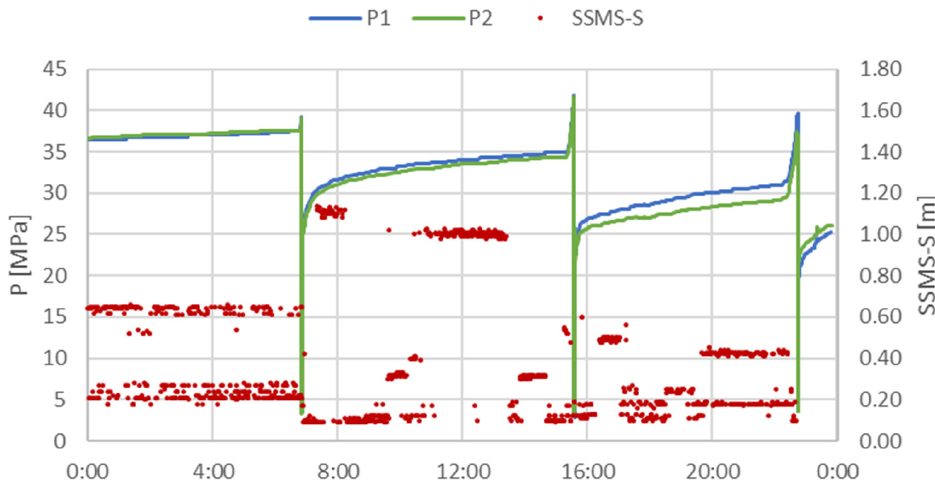
Figure 11. Roof support No. 59 pressure and tip-to face distance (15 February 2021).